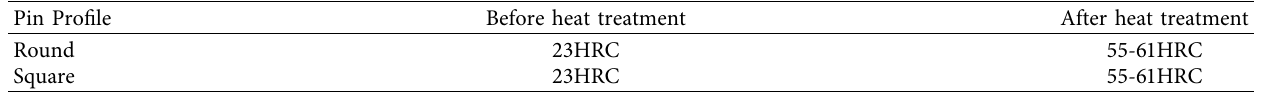
Table 3: Hardness test of H13 steel tools.